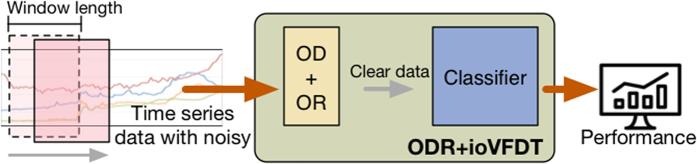
ODR-A-ioVFDT Model.